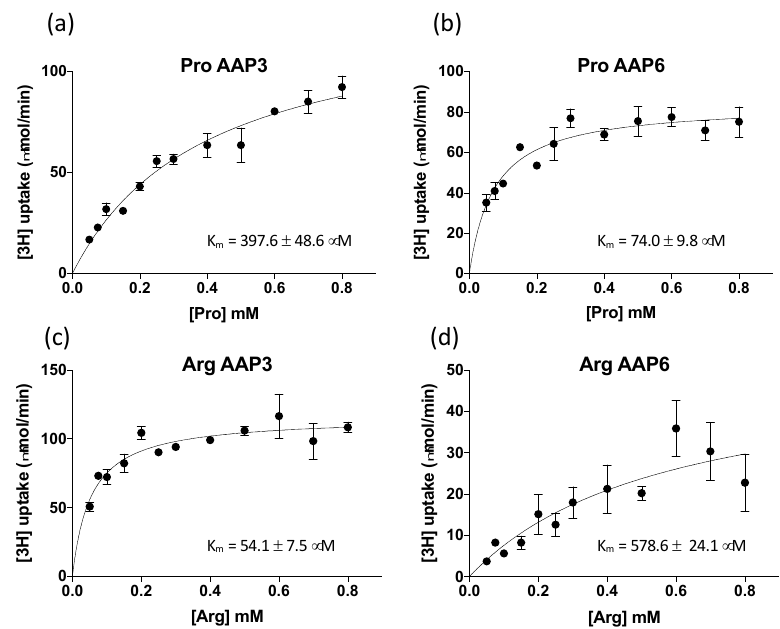
Figure 4. Concentration dependence of Pro and Arg uptake for ClAAP3 and ClAAP6. ( a ) and ( b ) [ 3 H] Pro uptake into yeast 22 ∆ 10 α cells expressing ClAAP3 ( a ) or ClAAP6 ( b ). ( c ) and ( d ) [ 3 H] Arg uptake into yeast 22 ∆ 10 α cells expressing ClAAP3 ( c ) or ClAAP6 ( d ). Values obtained from cells expressing the empty vector were used to normalize each data point. Michaelis–Menten kinetics were used to calculate Km values. Error bars represent standard deviation ( n =